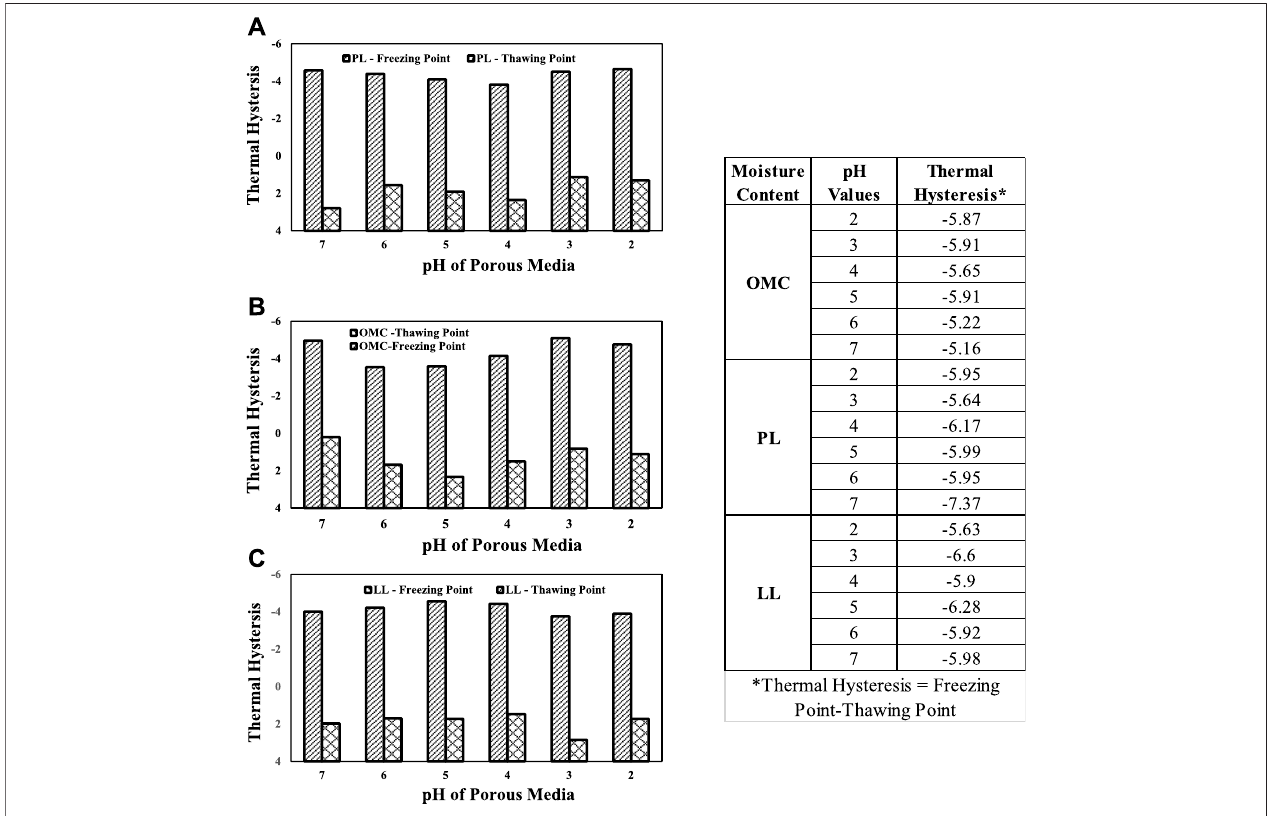
FIGURE 5 | Thermal hysteresis plots of clayey sand soil with different pH values and moisture contents: (A) plastic limit; (B) OMC; (C) LL.